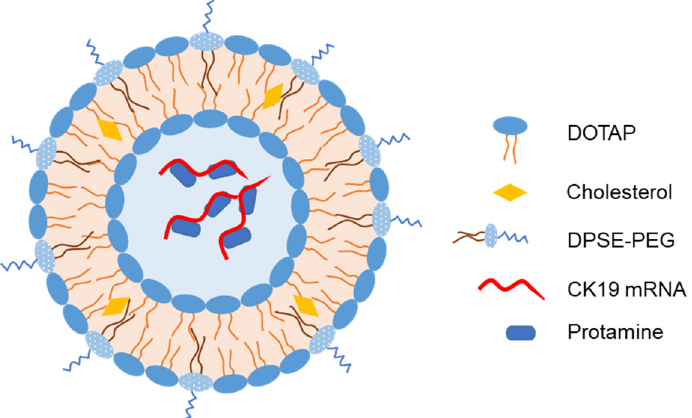
Figure 6. Representative structure of liposomes loaded with mRNA encoding cytokeratin 19 as an intranasal vaccine [71] .